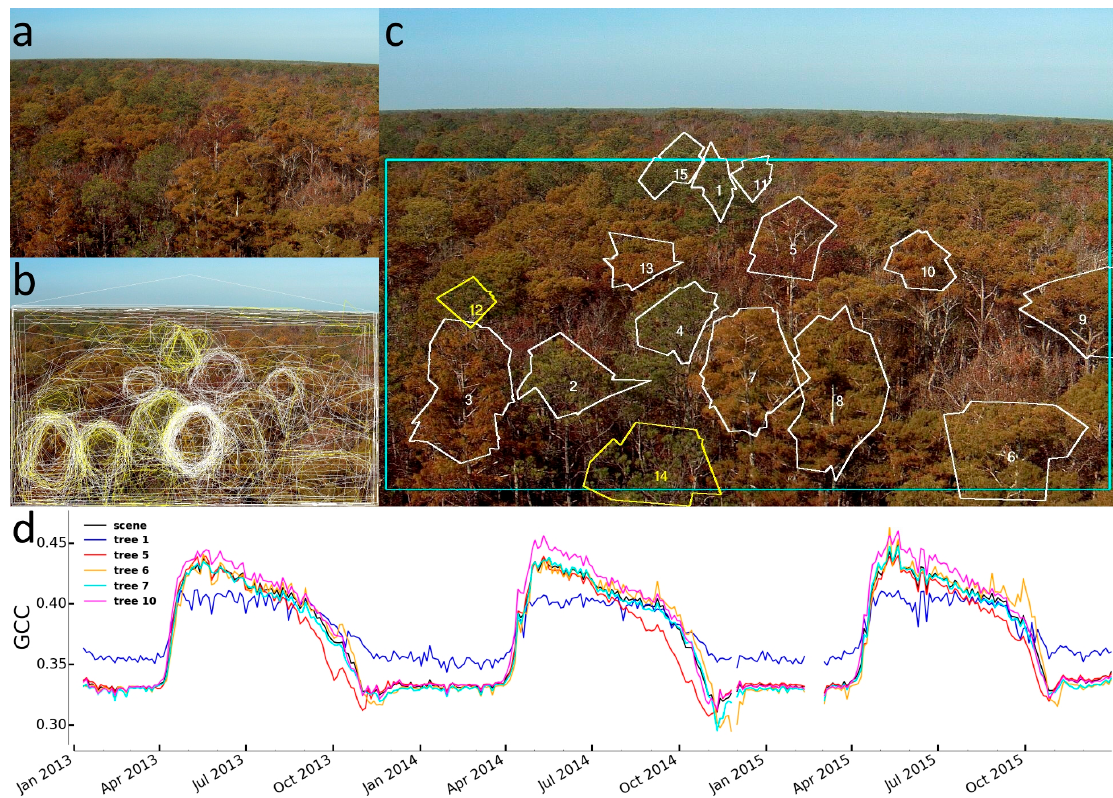
Figure 9. Identification of individual trees at the alligatorriver site. ( a ) Volunteers viewed a PhenoCam image; ( b ) they drew tree outlines on the image; here we show outlines from all volunteers for this site; ( c ) we calculated clusters of outline shapes, representing individual tree crowns (white and yellow). We also show a region (cyan) for calculating G CC for the entire scene; ( d ) G CC curves for five representative trees plus the G CC curve for the entire scene (black curve); tree 1 (blue curve) is loblolly pine ( Pinus Taeda), an evergreen; tree 5 (red curve) is red maple ( Acer rubrum ) and trees 6, 7, and 10 (orange, cyan, and pink curves) are pond cypress ( Taxodium distichum var. imbricarium ) which are deciduous; gaps in the curve are due to malfunctioning of the camera for those dates such that no images were taken those days.